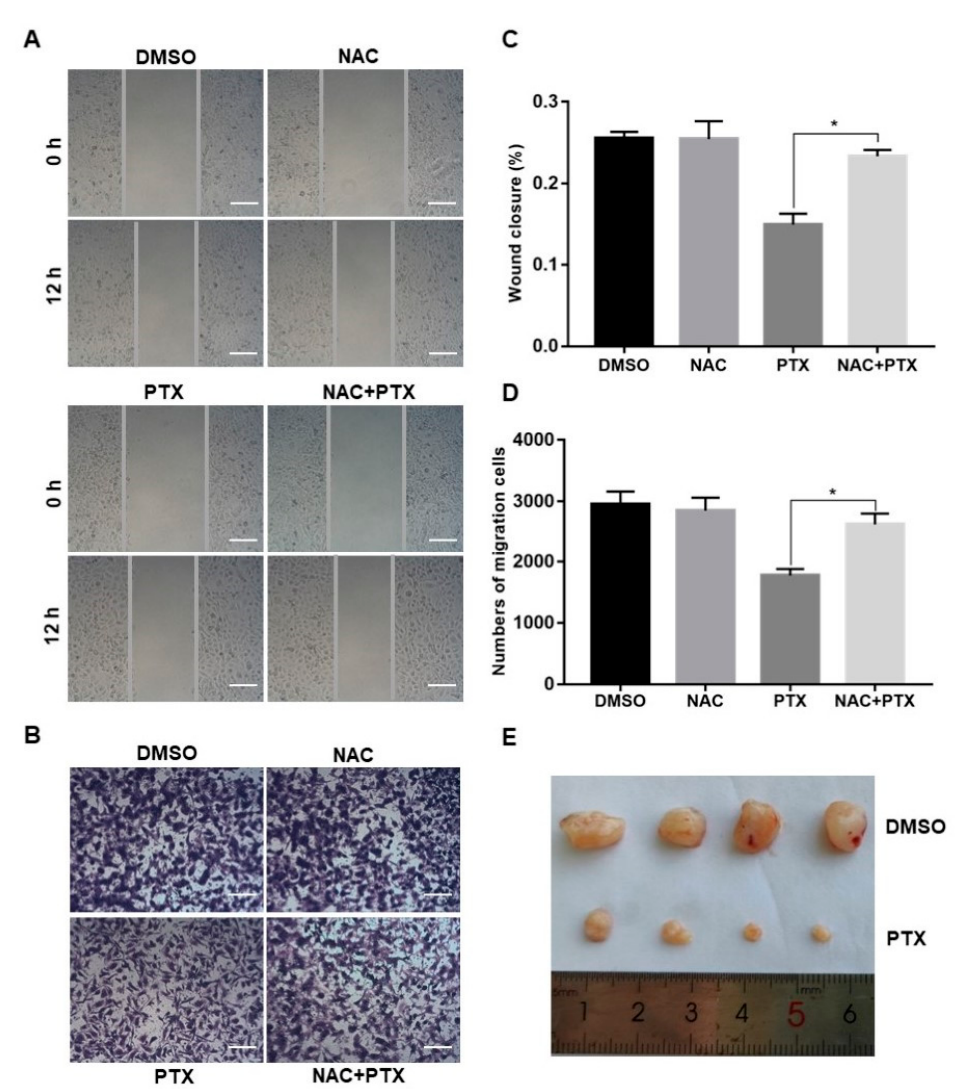
Figure 5. Paclitaxel inhibited cell migration and invasion in PC3M cells and suppressed prostate tumor growth in PC3M-xenografted tumor. ( A , C ) Cell scratch wound assay of PC3M treated with paclitaxel for 12 h. Cells were photographed at a magnification of 4 × (t = 0 h, t = 12 h) and analyzed using ImageJ software. Scale bars = 50 µ m. ( B , D ) Invasion assay of PC3M cells treated with paclitaxel for 24 h. Migrated cells were stained with crystal violet and photographed at five different areas at a magnification of 4×. Colored cells were counted and analyzed statistically. Scale bars = 50 μ m. ( E ) After 2 weeks, mice were sacrificed, and tumors were isolated and photographed. Results are expressed as mean ± SD, n = 3. *: p < 0.01.